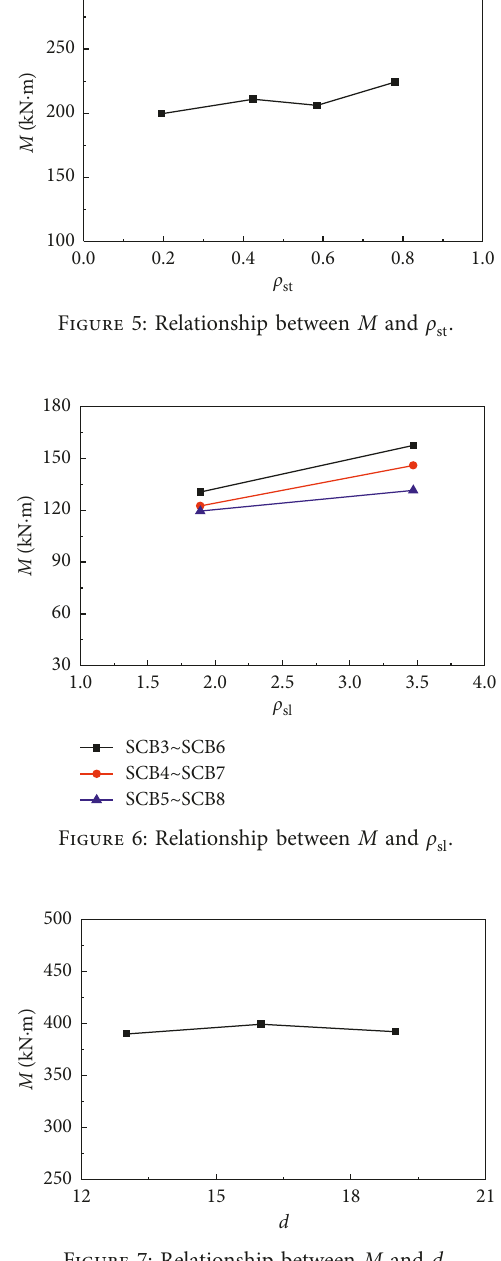
Figure 7: Relationship between M and d